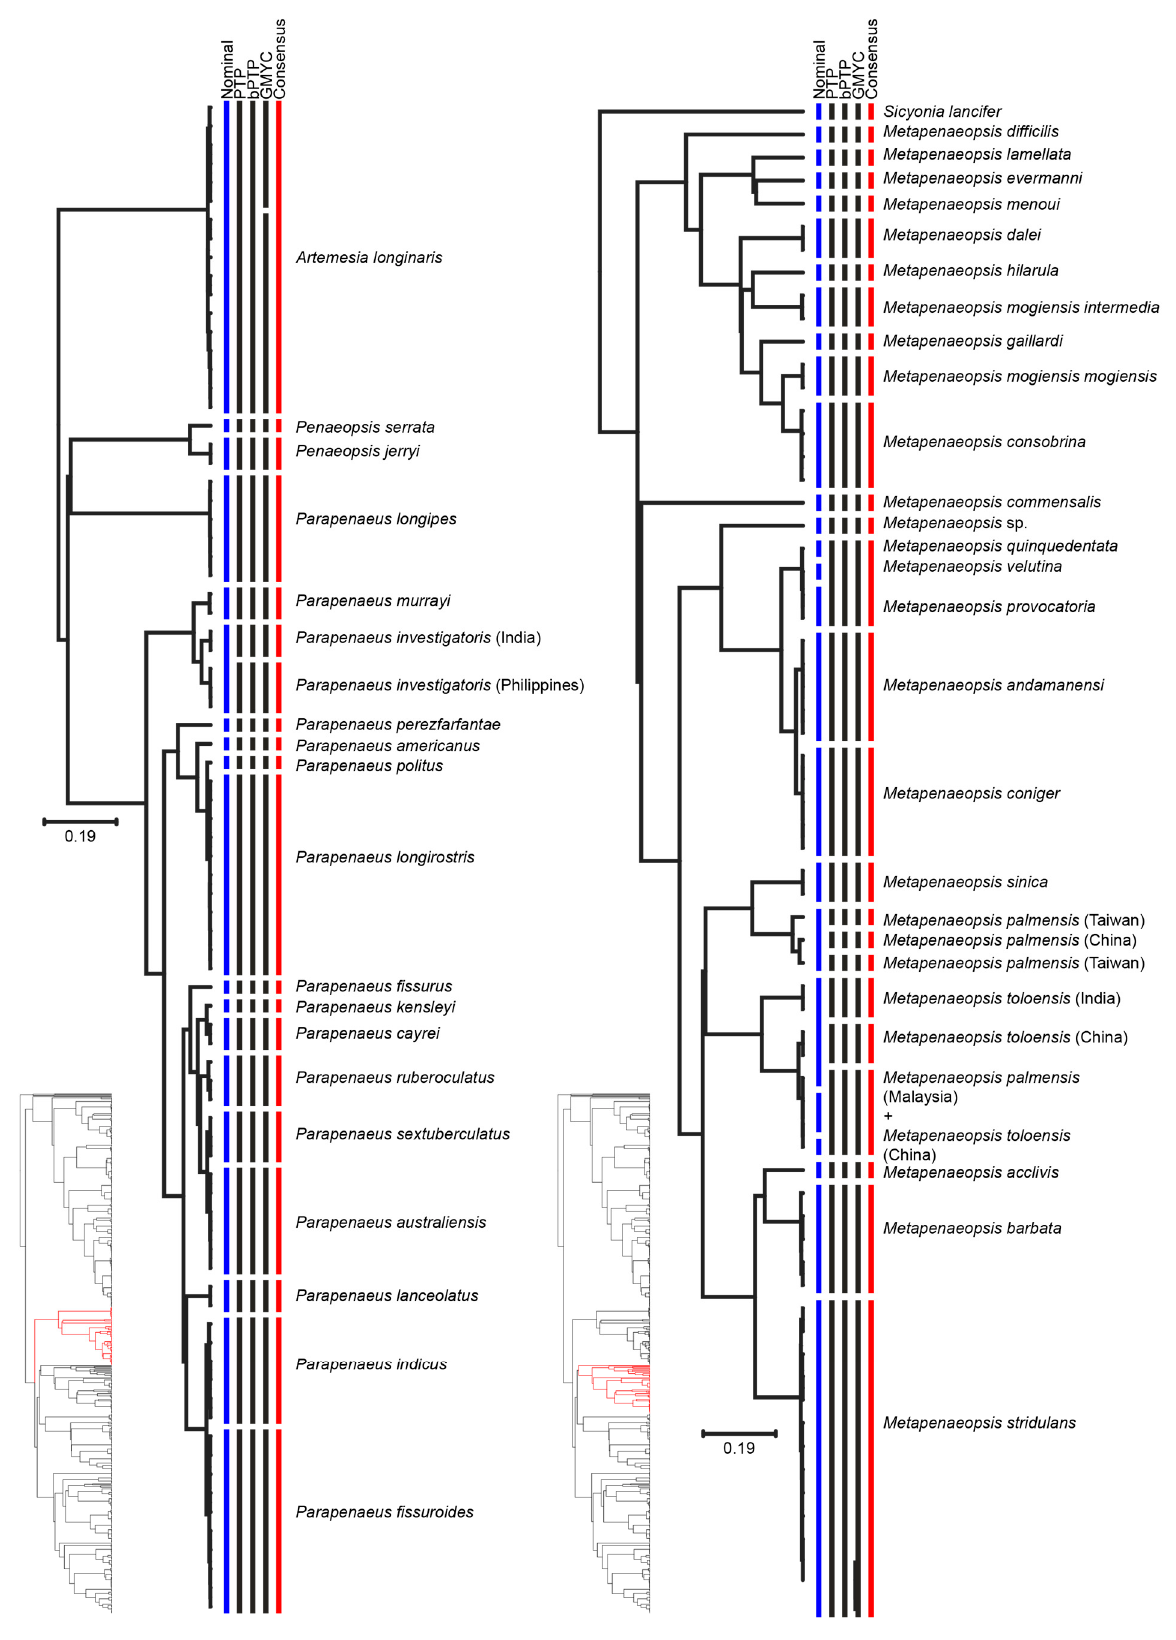
Figure 3. Bayesian tree showing the clustering of the MOTUs obtained by the species delimitation analyses for the genera Artemesia , Parapenaeus , Penaeopsis , Metapenaeopsis , and Sicyonia .